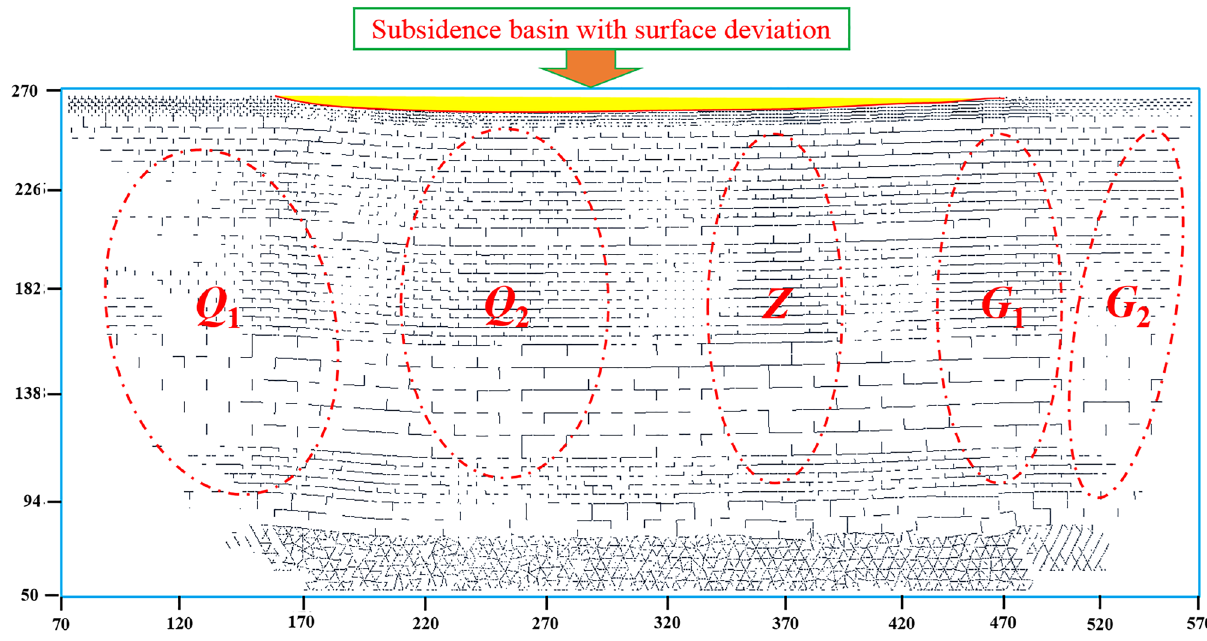
Figure 8. Development law of mining crack field. ( Q 1 ) The crack area outside the open-off cut. ( Q 2 ) The crack area inside the open-off cut. ( Z ) The re-compaction area in the middle goaf. ( G 1 ) The crack area behind the longwall face. ( G 2 ) The crack area in front of the longwall